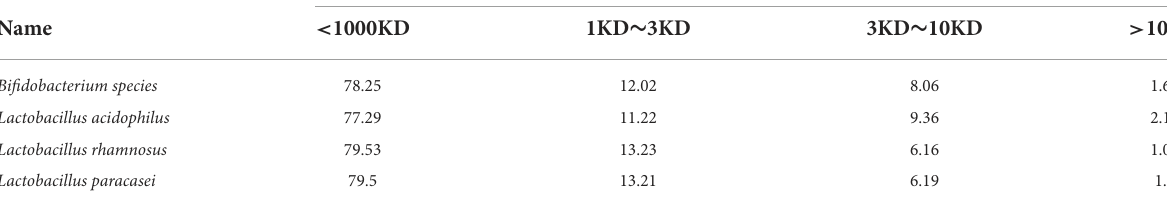
TABLE 1 Molecular weight distribution of fermentation peptides of four strains.